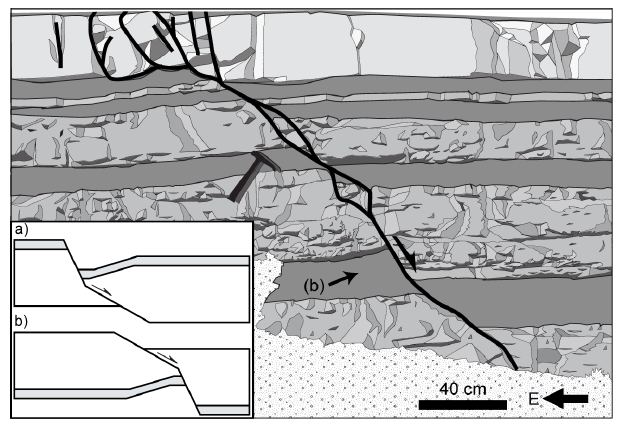
Figure 7. Outcrop sketch of a small normal fault from the Mesozoic Southeastern Basin of France (after Roche et al., 2012). Pronounced reverse drag in the footwall of the fault occurs below the upward shallowing of the fault surface to display the geometry illustrated in the inset (b) . Inset (a) is copied from Fig. 1, and (b) is (a) rotated through 180 ◦